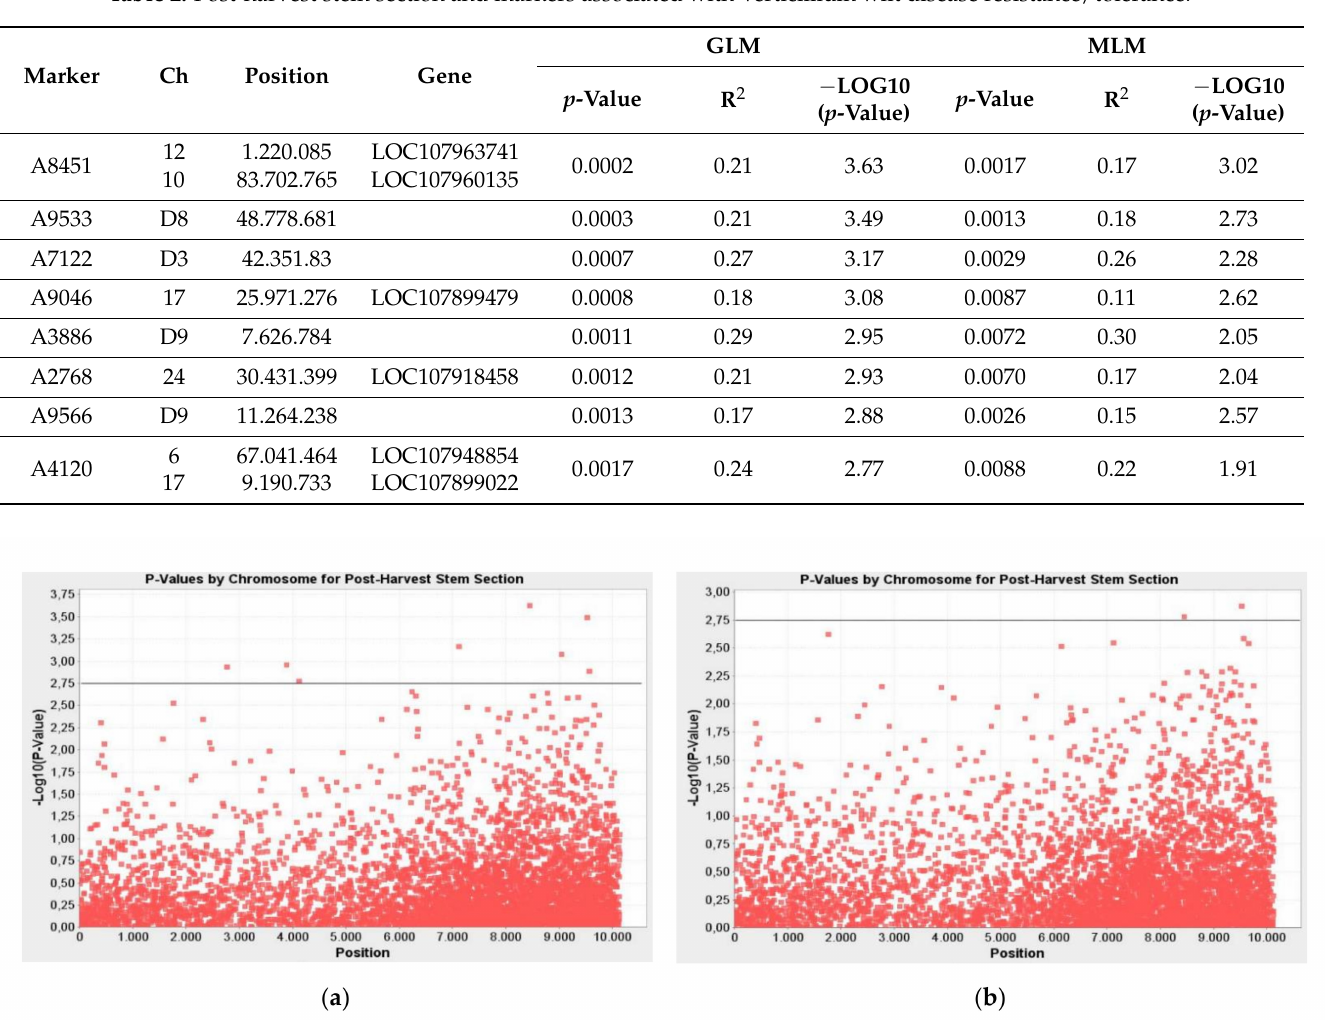
Figure 2. Manhattan plots for post-harvest stem section and markers associated with Verticillium wilt disease resis- tance/tolerance; ( a ) GLM; ( b ) MLM; the line indicates the significance threshold (-LOG10( p -Value) <